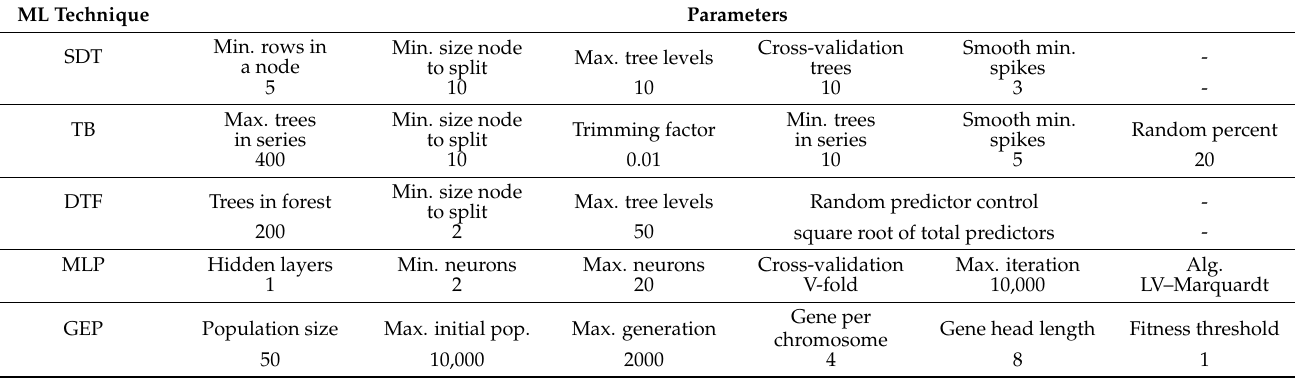
Table 4. Parametric summary of adopted